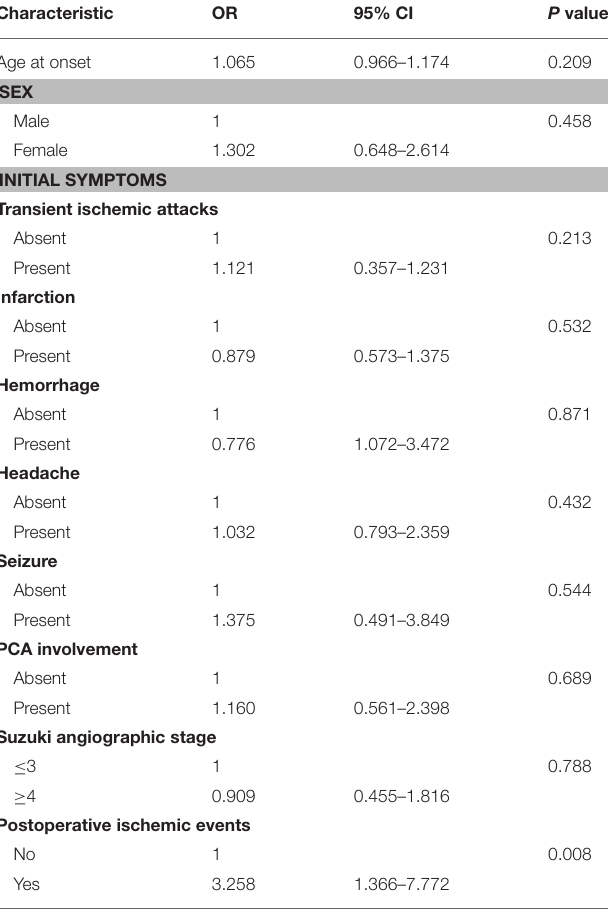
TABLE 5 | Multivariate logistic regression analysis for predictive factors of unfavorable surgical outcome. Characteristic